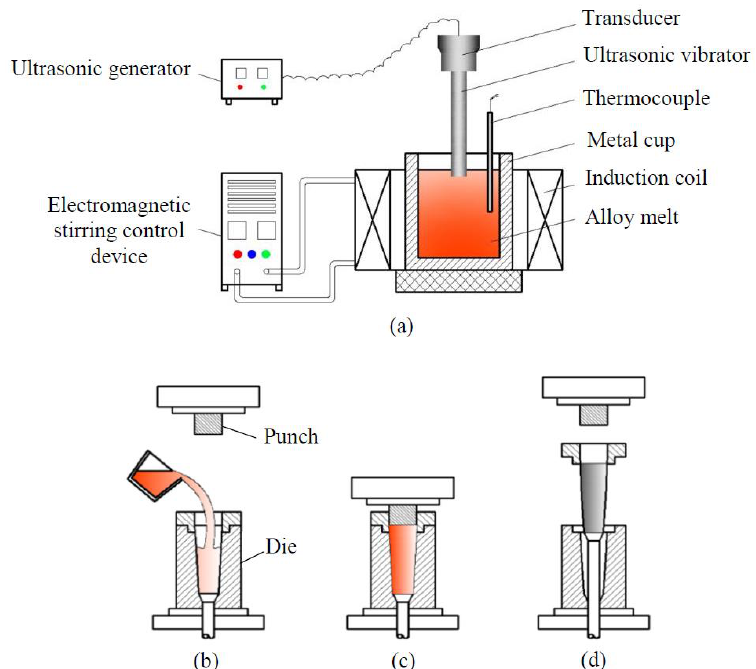
Figure 1. High pressure rheo-squeeze casting (HPRSC) process schematic diagram: ( a ) Melt treatment under ultrasonic vibration and electromagnetic stirring (UV-ES) compound field; ( b ) Pouring of melt; ( c ) Solidification under pressure; ( d ) Mold opening and ingot ejection.